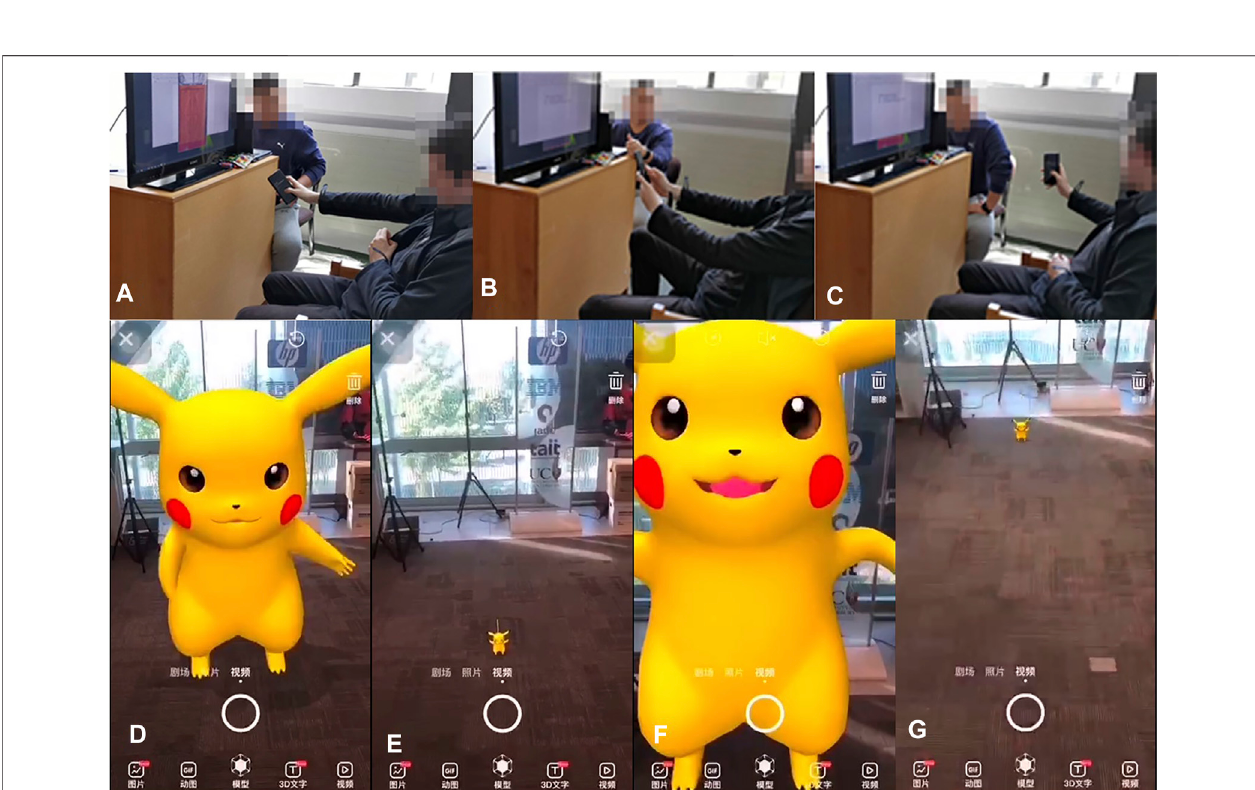
FIGURE1| Experimentalsetupandscreencaptures:Topimages (A – C) aparticipantperformsagesturewhilewatchingavideodisplayedonaTVscreen.Bottom images (D – G) screen captures from the CooolAR application for the Scale Down task shown to the participants on the TV screen. (D,E) show a start and an end frame, respectively, ofavideo capture withastationarybackgroundtosuggest asurfacegesturetobeperformed. (F,G) showtheframesofavideowithamoving background suggesting a motion gesture to be performed.